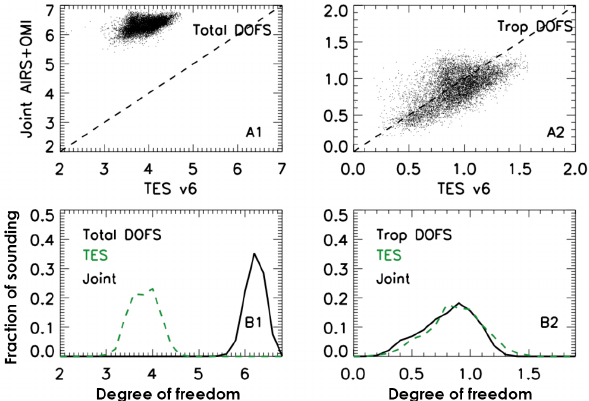
Figure 4. DOFS for O 3 over globe shown in Fig. 3. Here, we used the A-Train measurements from August 2006. Results for the remaining months of 2006 are available in Figs. S12–S22 in the Supplement. (A1) Total DOFS; (A2) tropospheric DOFS; (B1) his- togram of total DOFS: joint AIRS + OMI (black line) and TES ver- sion 6 (green dashed line); and (B2) histogram of tropospheric DOFS joint AIRS + OMI (black line) and TES version 6 (green dashed